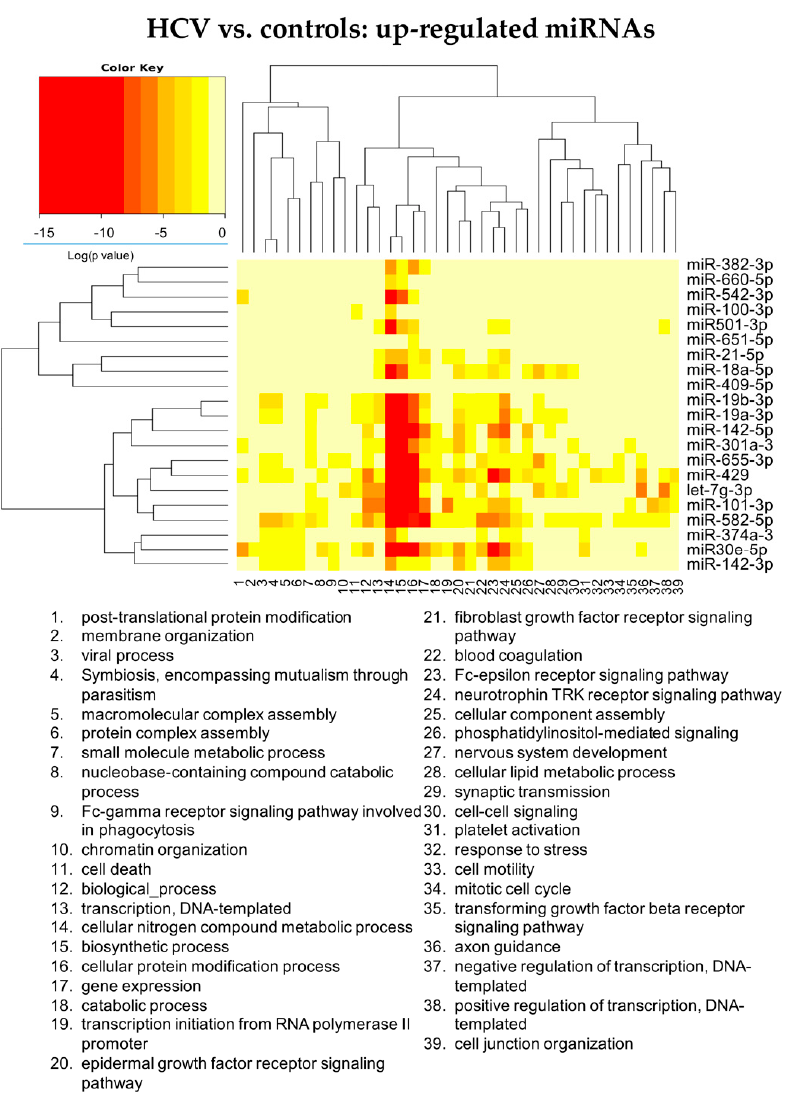
Figure 2. Heatmap showing the significance (see color key) of the association of up-regulated miRNAs with “Gene Ontology-Biological Process” categories, as identified applying the “Categories Union” method.